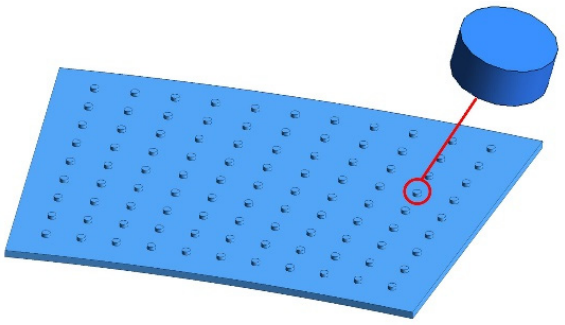
Figure 5. Schematic diagram of friction pair structure.